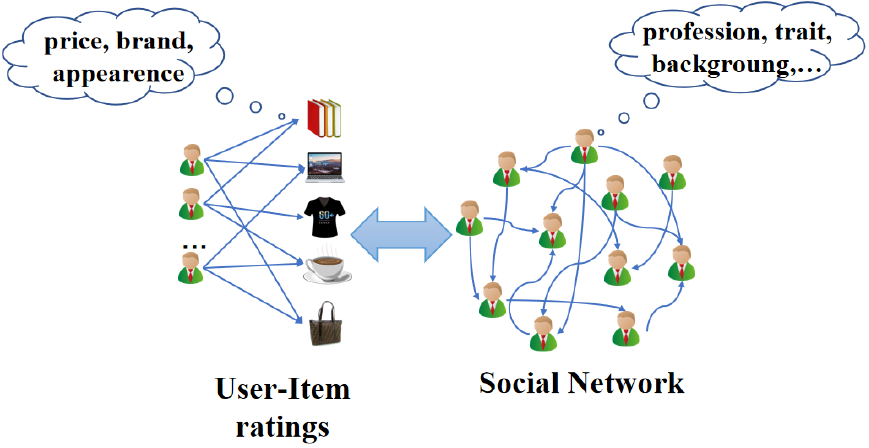
Figure 2. Social scene and shopping scene.